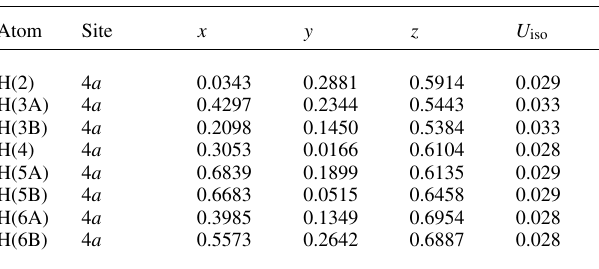
Table 2. Atomic coordinates and displacement parameters (in Å 2 )